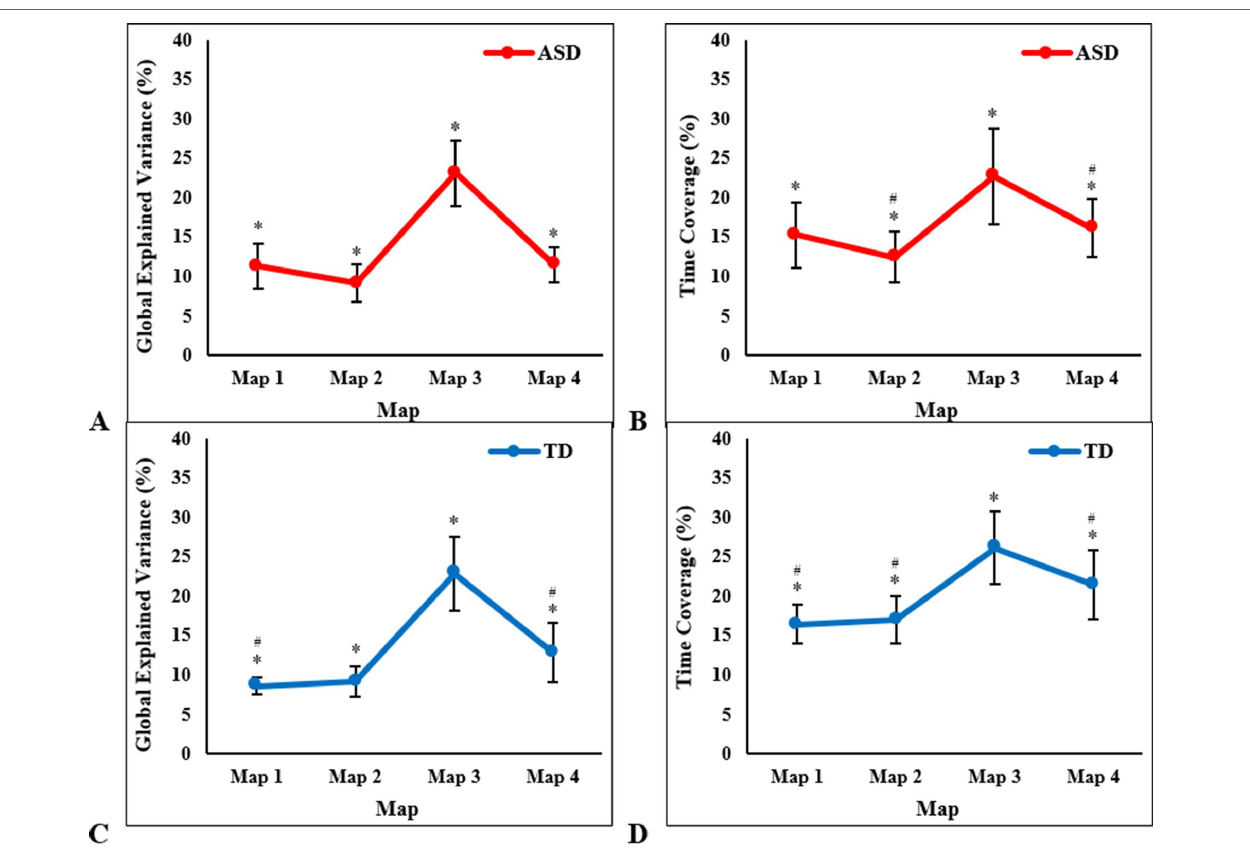
FIGURE 3 | One-way ANOVA results showing significant between-map differences in children with autism spectrum disorder (ASD), in mean (± SD): (A) global explained variance and (B) time coverage; and in typically developing (TD) children, in mean (± SD): (C) global explained variance and (D) time coverage. *Significant post hoc tests with Map 3, # significant post hoc tests with Map 4, at P < 0.003 (Bonferroni-adjusted).